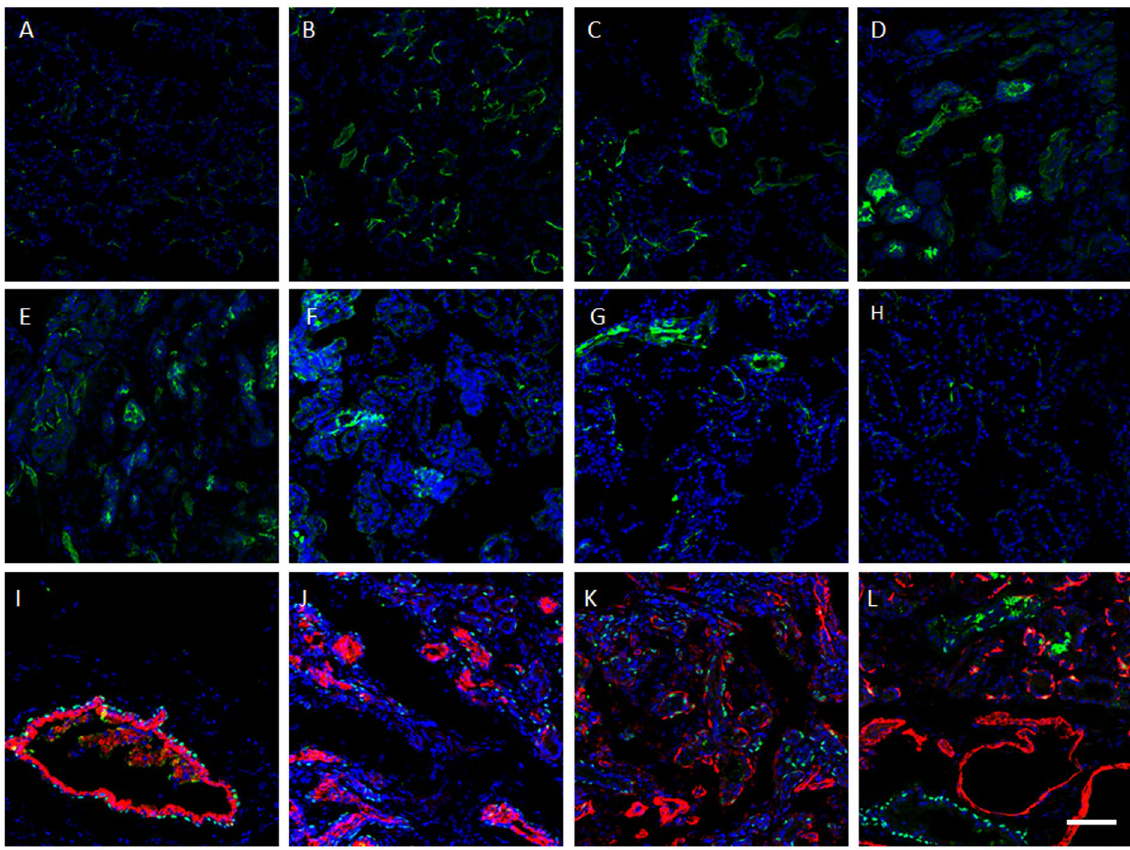
Figure 4. Immunostaining in lacrimal glands after ligation-induced injury. Immunofluorescence staining of nestin ( A – H , green); ∆ Np63 ( I – J , green); K4 ( I , J , red) and SMA ( K , L , red) on control lacrimal gland ( A ), and samples 0 ( B ), 1 ( C ), 3 ( D ), 7 ( E , I – L ), 10 ( F ), 20 ( G ) and 30 ( H ) days post-reopening of the main excretory duct. Blue is DAPI staining. Bar represents 100 μ